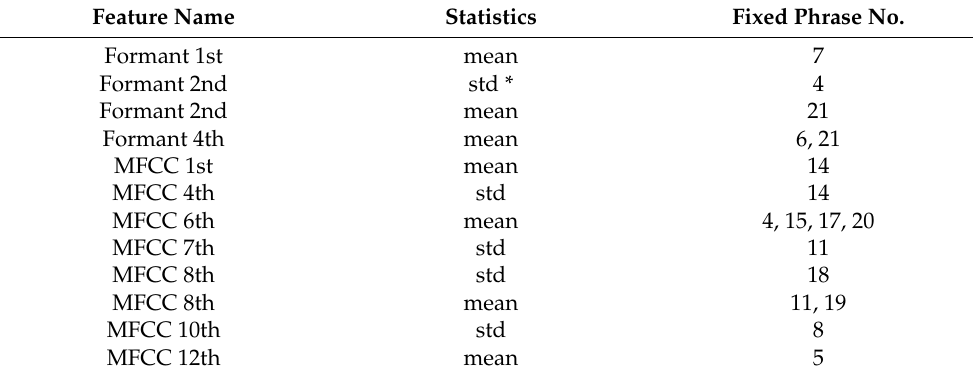
Table 8. Common acoustic features in the decision